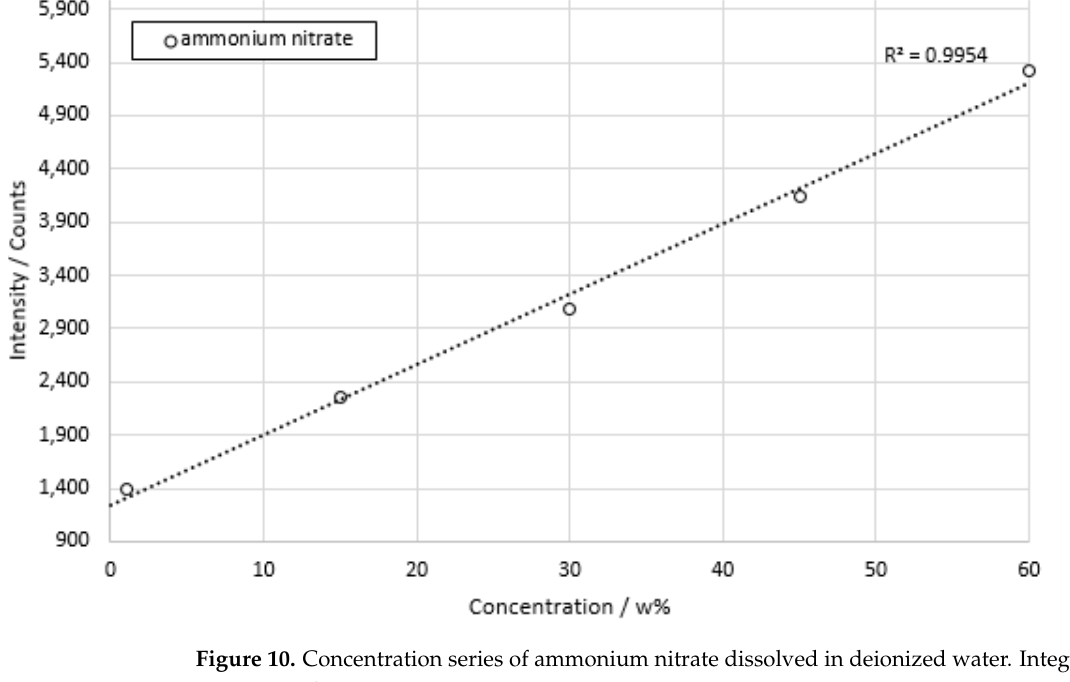
Figure 10. Concentration series of ammonium nitrate dissolved in deionized water. Integration time 100 ms; total measuring time 2 min per concentration.